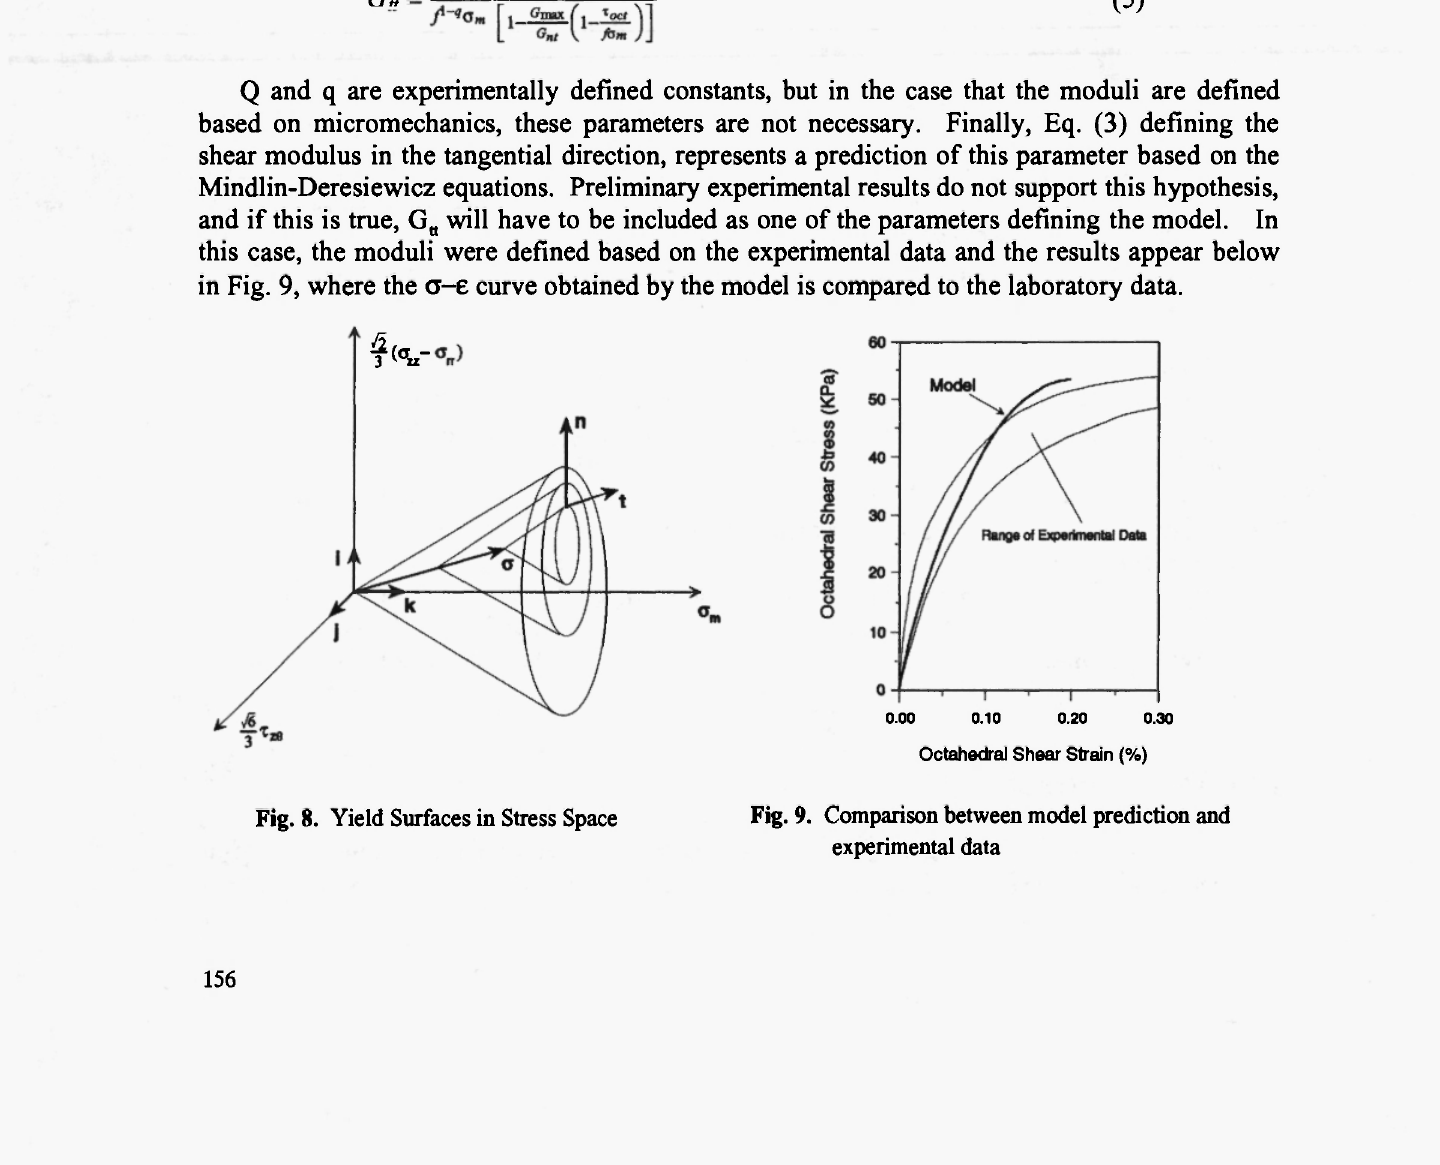
Fig. 8. Yield Surfaces in Stress Space Fig. 9. Comparison between model prediction and